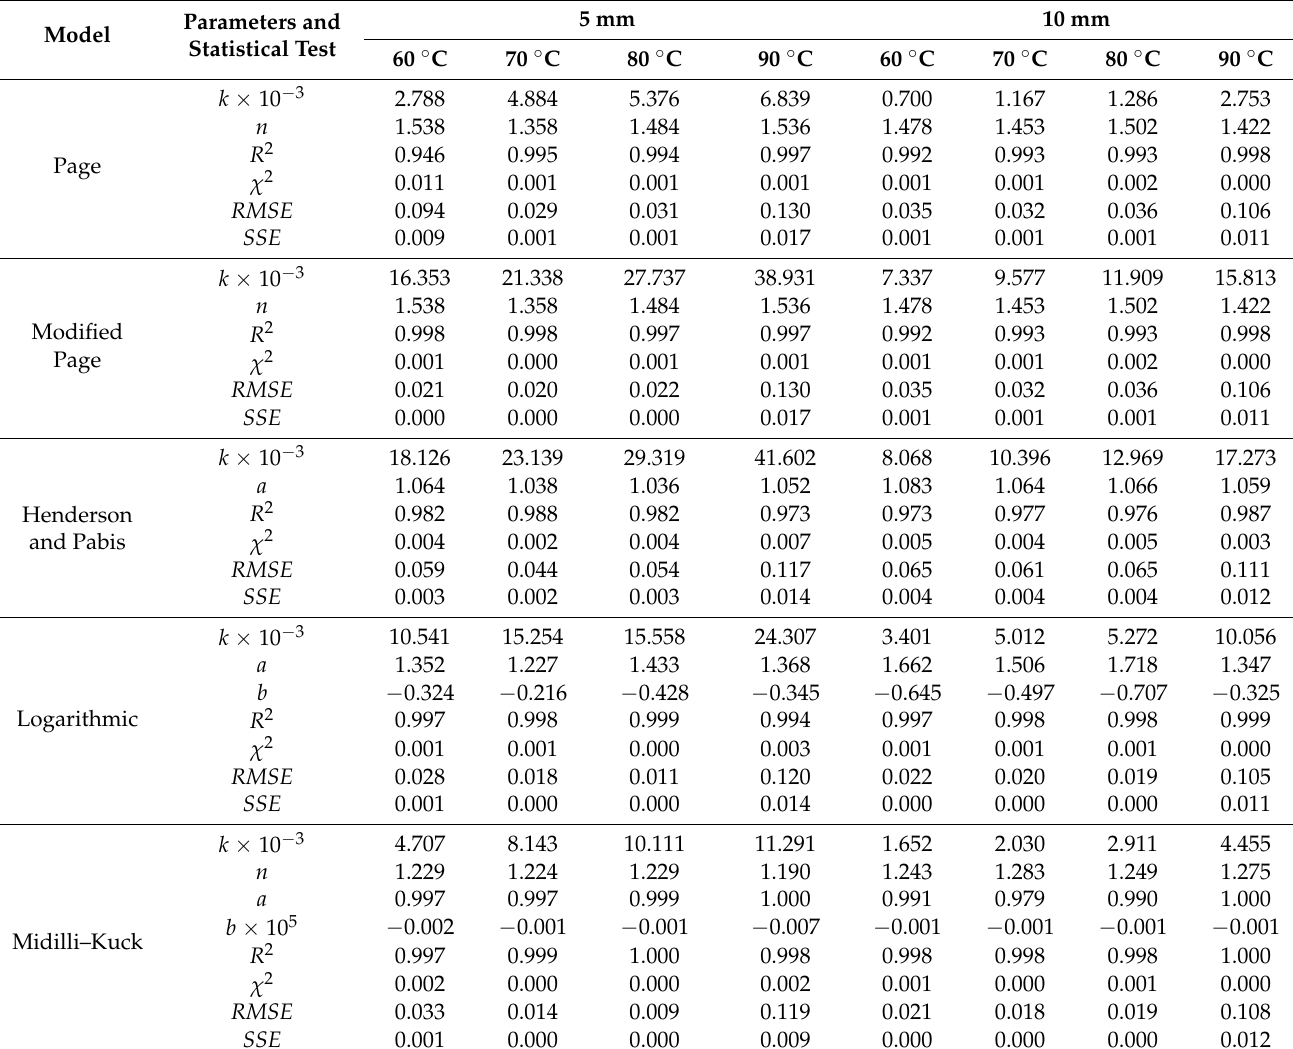
Table 3. Model parameters and statistical results for Aloe vera gel slabs drying in this work.